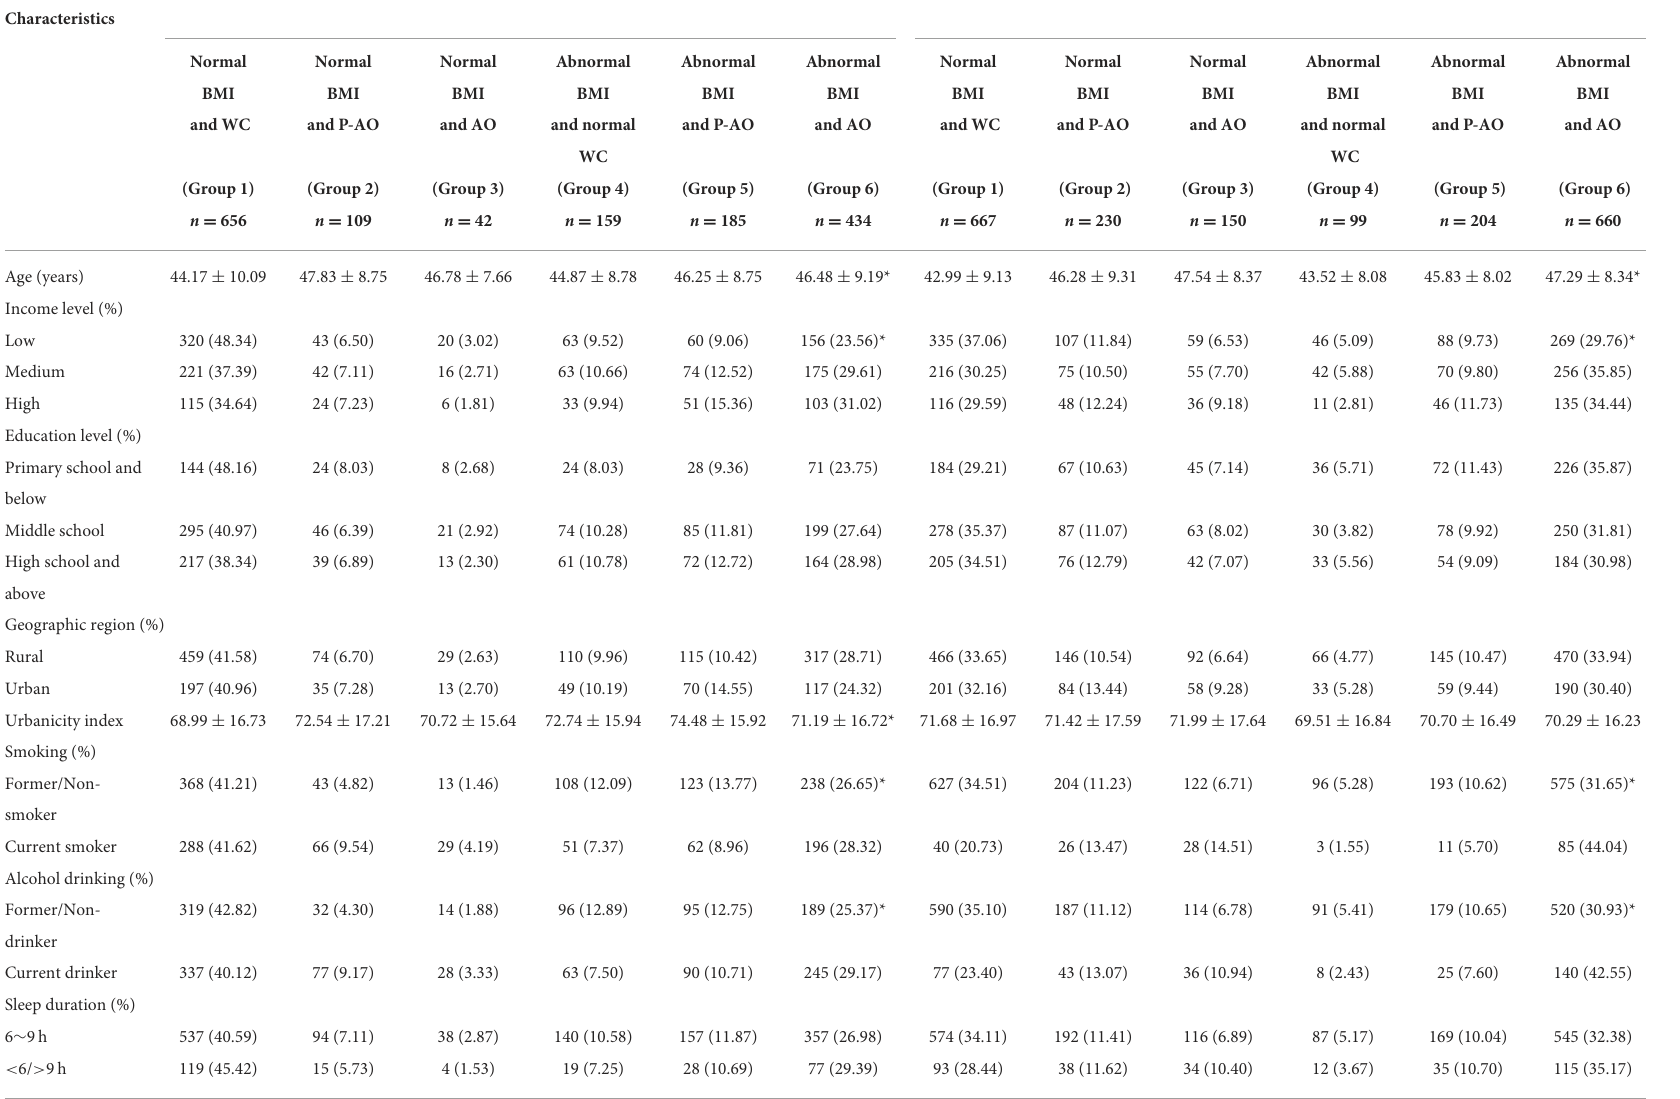
TABLE 1 Baseline characteristics of adults across obesity profiles stratified by gender, CHNS † .